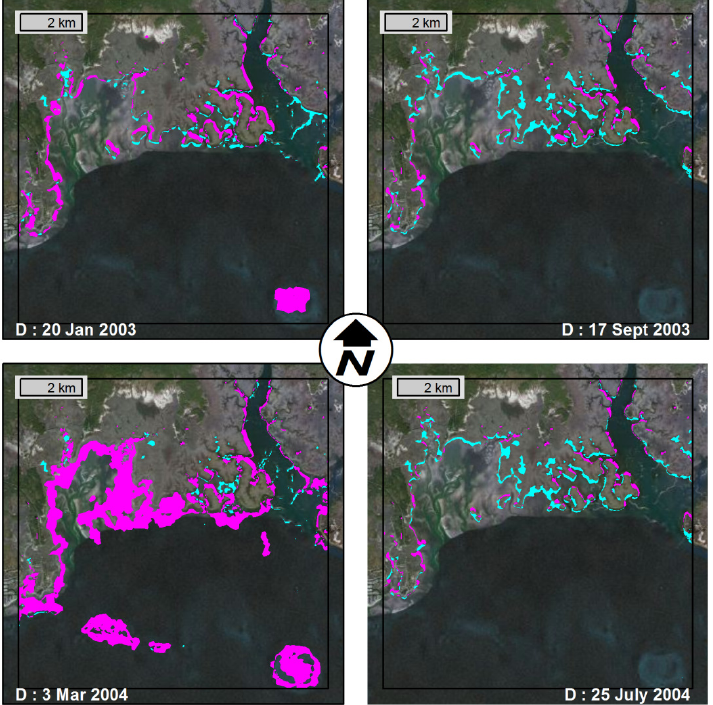
Figure 10. Synoptic inundation results for Assessment Area D (Apalachee Bay). Pixels incorrectly predicted as DRY are shown in magenta; pixels incorrectly predicted as WET are shown in cyan. Other areas within the square boundary were correct.